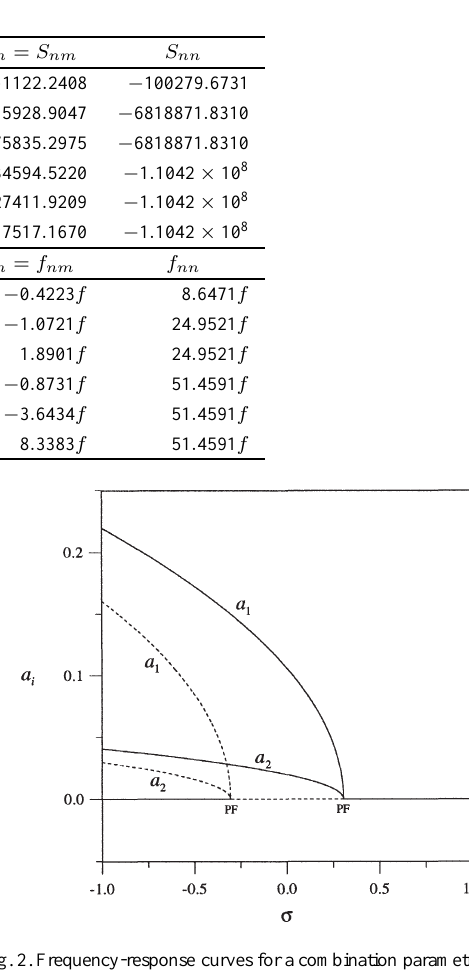
Fig. 2. Frequency-response curves for a combination parametric res- onance of the additive type involving modes 1 and 2 for f =